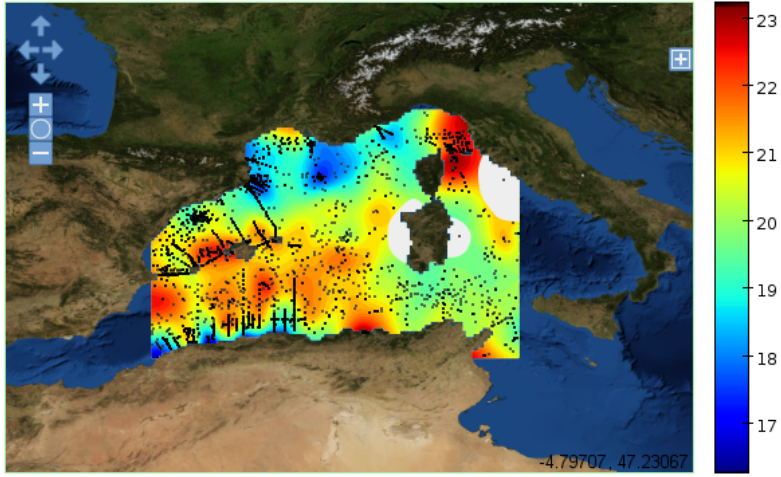
Fig. 6. Overlay of several layers: analysis, observations and error mask hiding regions where the relative error of the analysis is larger than